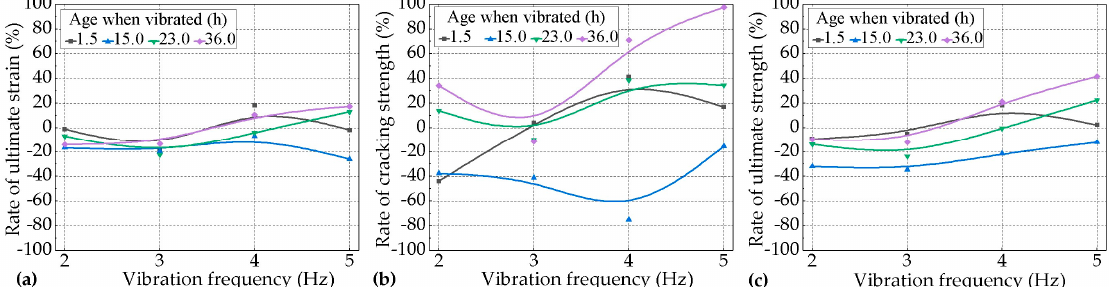
Figure 8. Rates of ( a ) the ultimate tensile strain, ( b ) cracking strength, and ( c ) ultimate tensile strength for the vibrated groups over the control group with the increase of the levels of vibration frequency at different ages with a duration of 5.0 h (Var. 1).